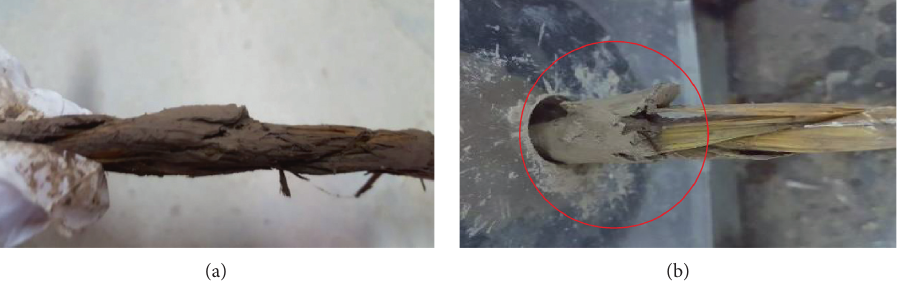
y = –0.0018 x 3 + 0.280 x 2 – 15.296 x + 554.382 R 2 = 0.9947